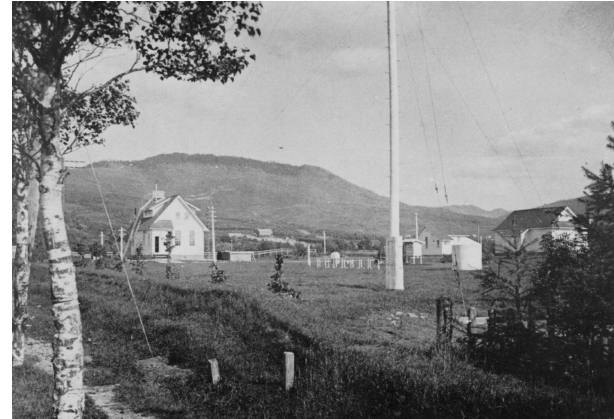
Figure 15. Toyohara Magnetic Observatory (later known as Yuzhno-Sakhalinsk Magnetic Observatory) (photo supplied by Kakioka Magnetic